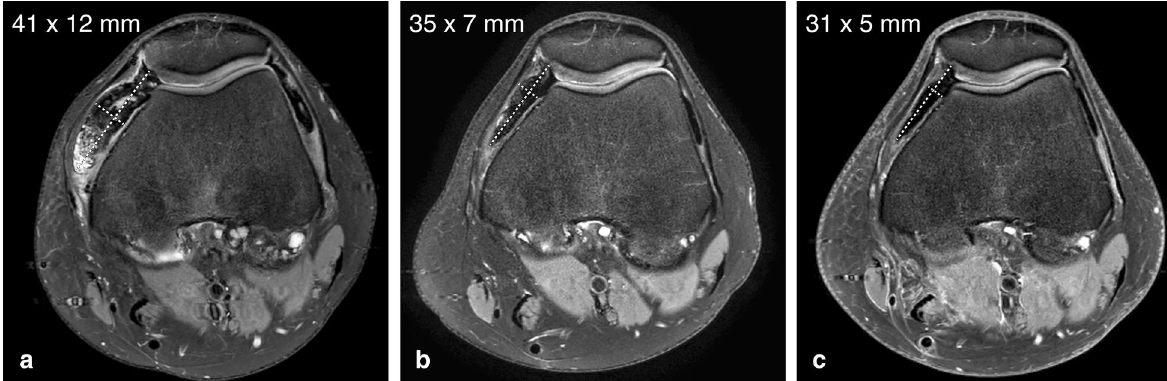
Fig. 7 MRI findings after treatment of D-TGCT with a CSF1R inhibitor. a Axial PD SPAIR images in a patient with intra-articular D-TGCT. Baseline image showing a target lesion (two axial diameters measured according to modified RECIST, dotted lines) in the medial suprapatellar recess. Note a smaller similar lesion in the lateral suprapatellar recess. b After 8 weeks on CSF1R-inhibitor therapy, the tumour showed a significant decrease in size and signal intensity. Joint effusion was resolved (not shown). The patient experienced improvement in symptoms of pain and swelling. c After